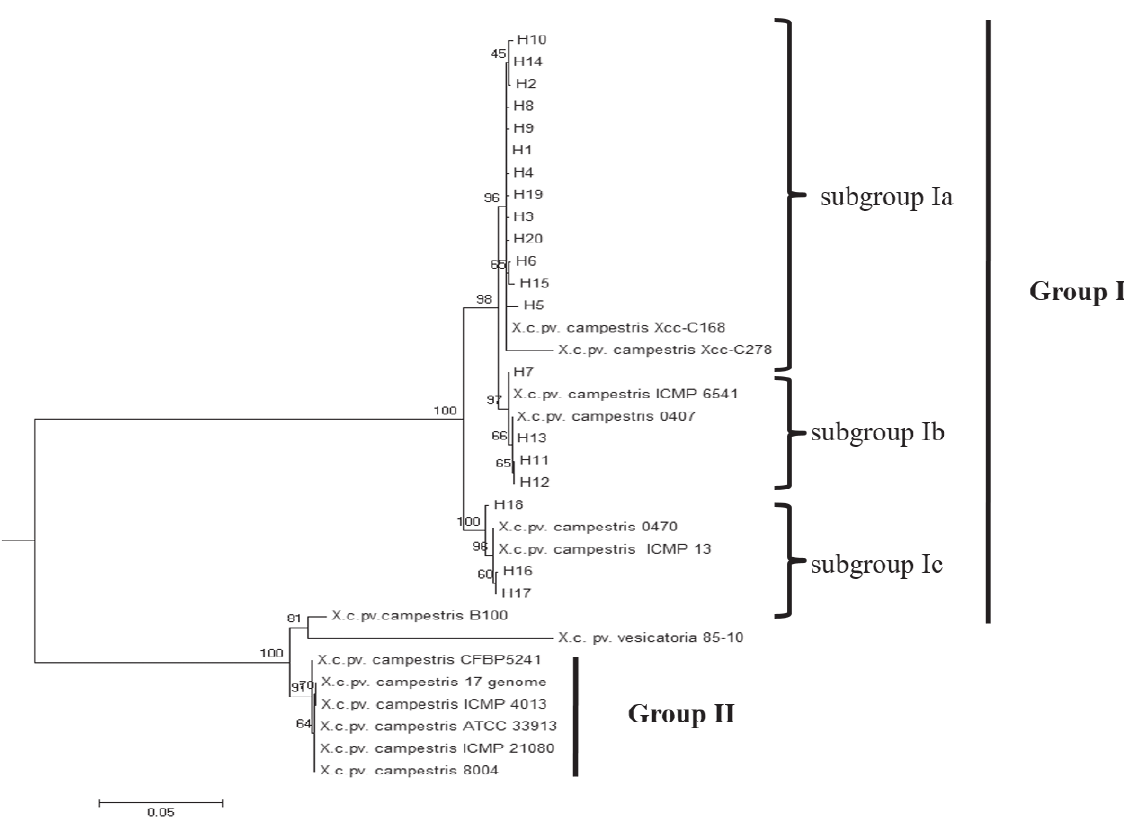
Figure 3. Maximum likelihood tree constructed with concatenated partial sequences of two housekeeping gene ( gyrB and rpoD ) of 20 Alge- rian haplotypes and 13 Xanthomonas campestris pv. campestris international strains, and rooted with Xanthomonas campestris pv. vesicatoria . Bootstrap percentages obtained for 1000 replicates are indicated at each